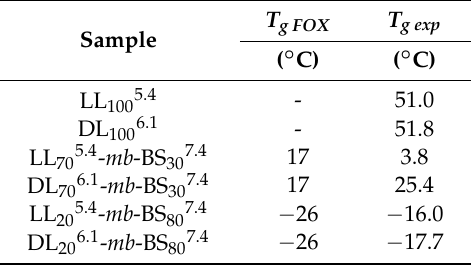
Table 3. Values of T g estimated employing the Fox equation ( T g FOX ) and the experimental values ( T g exp ) from the second heating scan at 20 ◦ C/min for the indicated samples. T g Sample